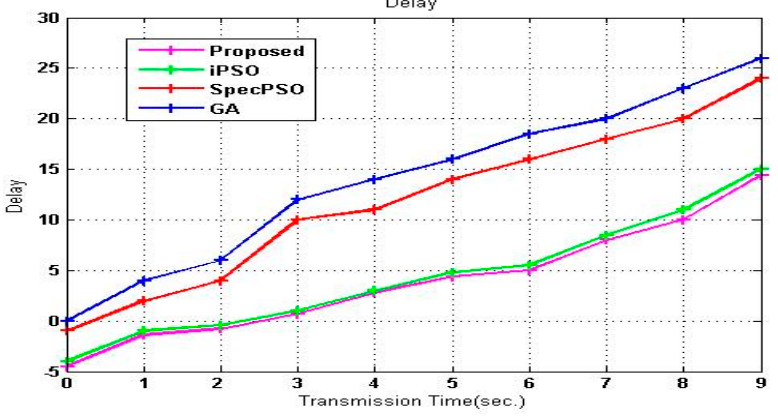
Figure 7. Delay vs. transmission time.